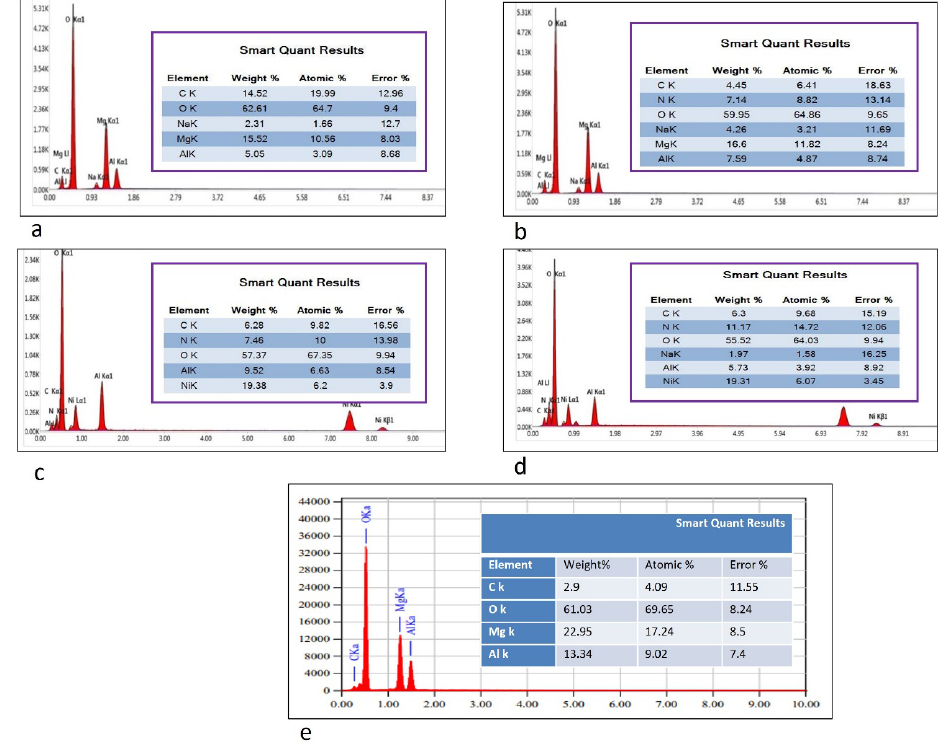
Figure 6. ( a ) represents SEM-EDX component of synthesized MgLDH-GT, ( b ) represents SEM-EDX the elemental structur of synthesized MgLDH-F, ( c ) represents SEM-EDX the elemental structure